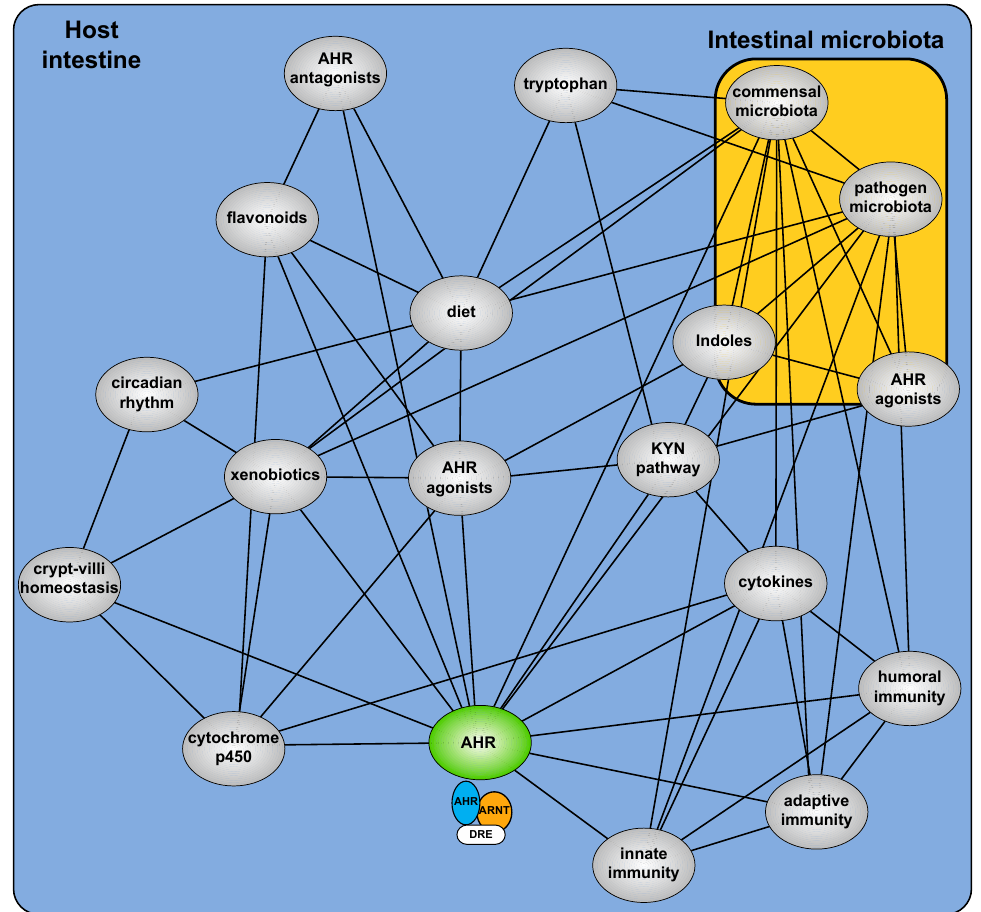
Figure 1. Overview of the AHR interactome and how it translates into effects on epithelium and innate immune surveillance.